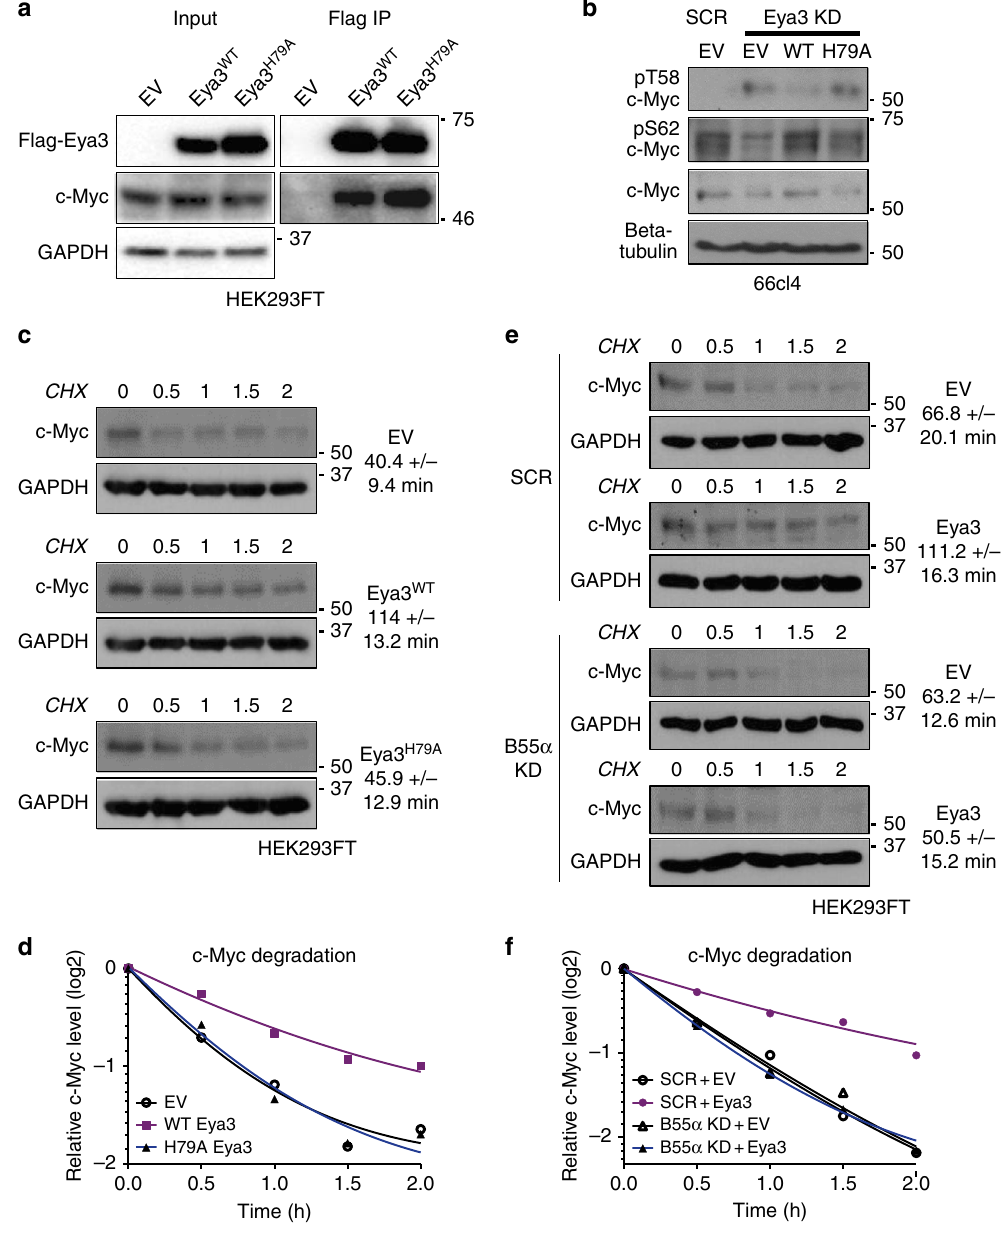
Fig. 5 Eya3 – PP2A-associated Thr phosphatase activity increases c-Myc stability. a IP from HEK293FT cells using a Flag antibody demonstrates Eya3 WT and Eya3 H79A both associated with c-Myc. Molecular weight markers in kilodalton are labeled on the side of western blots. b Western blot analysis shows pT58, pS62, and total c-Myc levels in SCR + EV, Eya3 KD + EV, Eya3 KD + WT, and Eya3 KD + H79A 66cl4 cells. c Cycloheximide chase assays were conducted using HEK293FT cells transfected with EV, Eya3 WT , or Eya3 H79A to measure c-Myc stability. Representative images of western blot analyses examining c-Myc levels in HEK293FT cells at various treatment time points are shown. d Quanti fi cation of relative c-Myc levels over the treatment